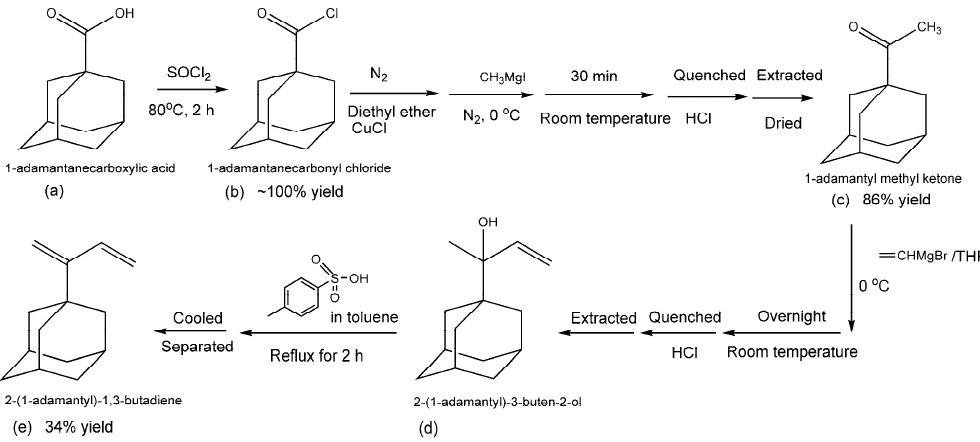
Figure 7. Synthesis of 2-adamantyl-1,3-butadiene [112,113].